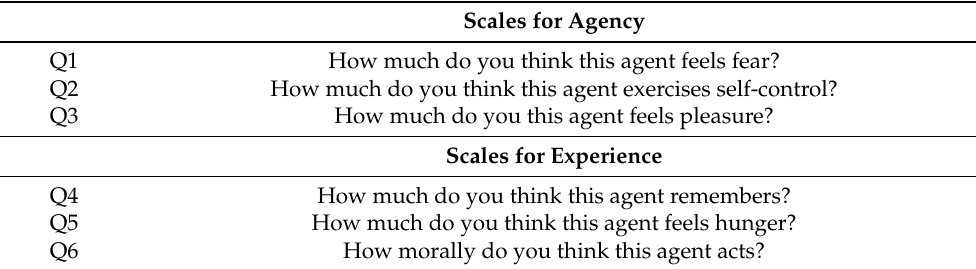
Table 1. Questionnaire in the pre-experiment survey.